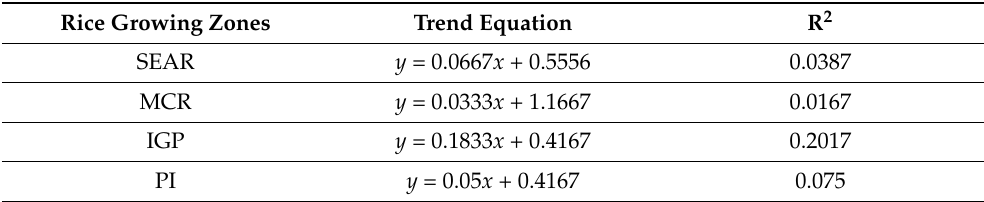
Table 14. Trend equation of rice agro-climatic suitability/non-suitability for SEAR, MCR, IGP and PI